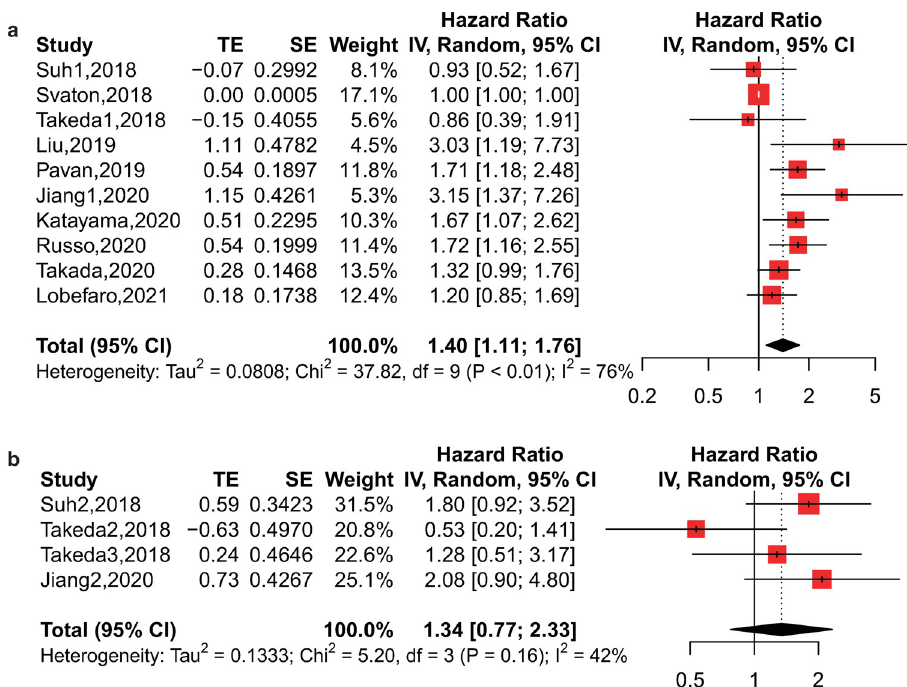
Fig 3. Forest plot of the association between PLR and PFS of lung cancer patients receiving immunotherapy. a) Forest plot of pretreatment PLR; b) Forest plot of posttreatment PLR.